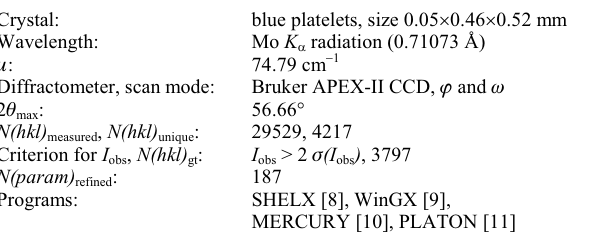
Table 1. Data collection and